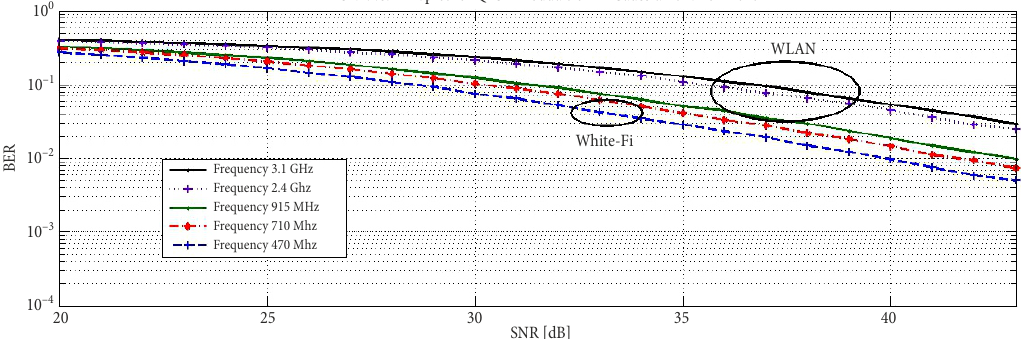
SNR vs. BER plot for QPSK modualtion in Gaussian environment